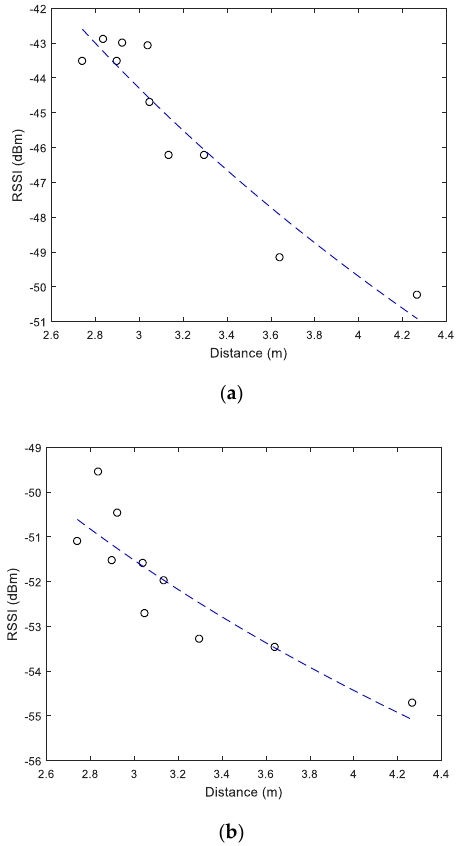
Figure 12. Nonlinear regression estimation of the relationship between the measured RSSI and the distance d: ( a ) indoor scenario, ( b ) outdoor scenario. Table 6. Comparison of actual locations with those obtained using MVPA for outdoor